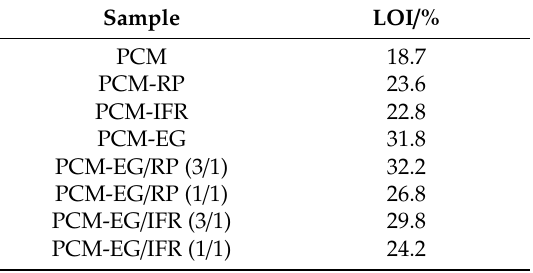
Table 1. Limiting oxygen index (LOI) values of different SSPCMs (acrylic resin/flame retardant = 10/5).